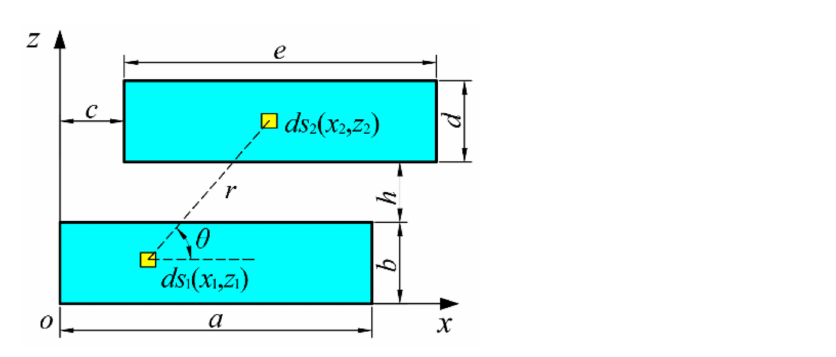
Figure 6. Schematic diagram of rectangular–rectangular combinations of permanent magnet units (CPMUs).